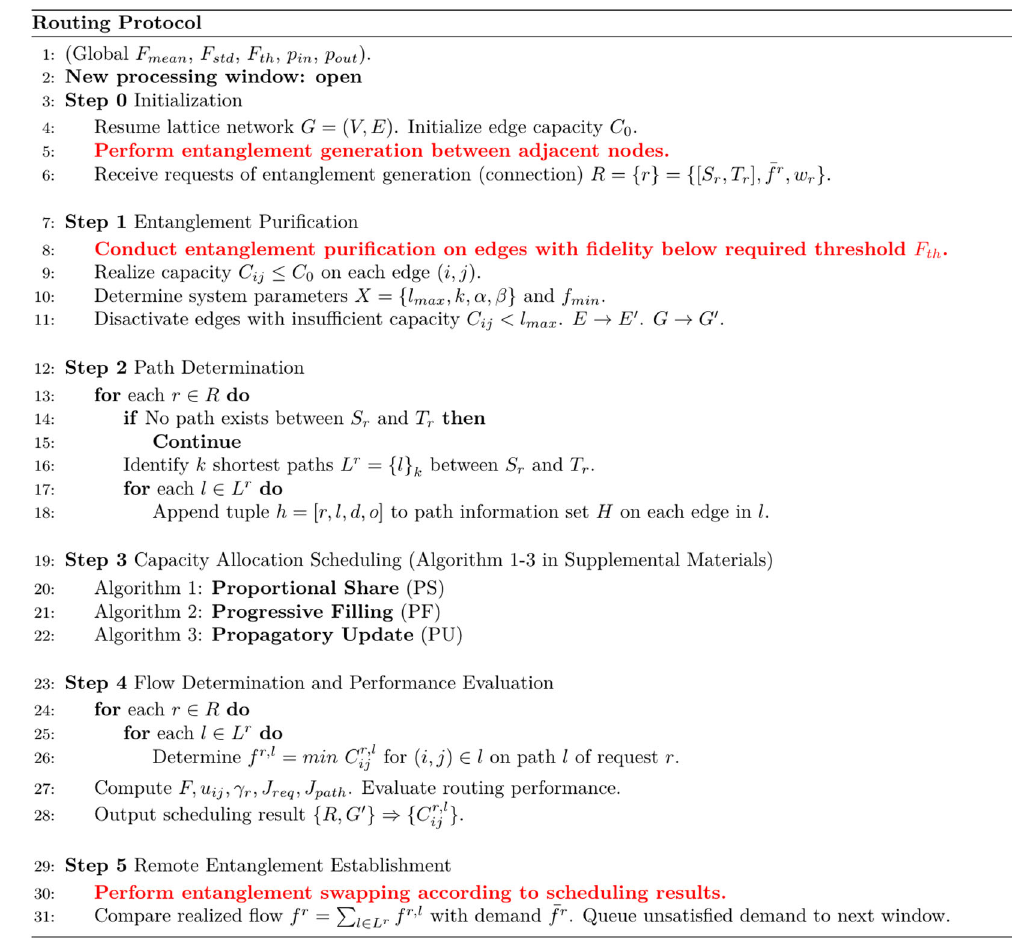
Fig. 2 Illustration of the routing protocol. Physical steps (in which quantum operations are physically conducted) are shown in